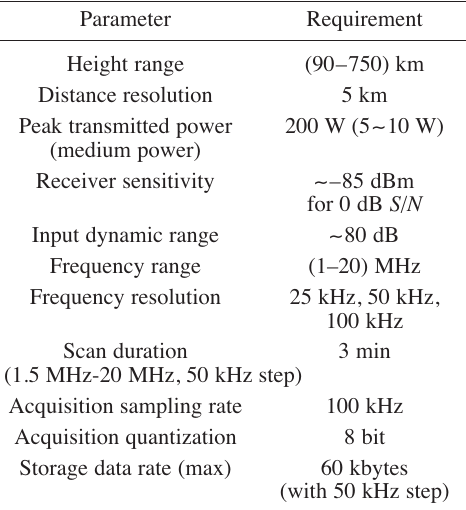
Table II. AIS-INGV programming parameters.